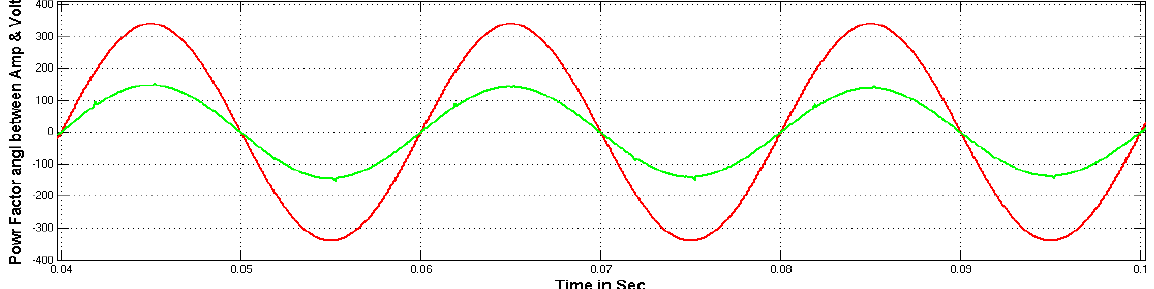
Figure 28. Filter currents from APF-1 and APF-2